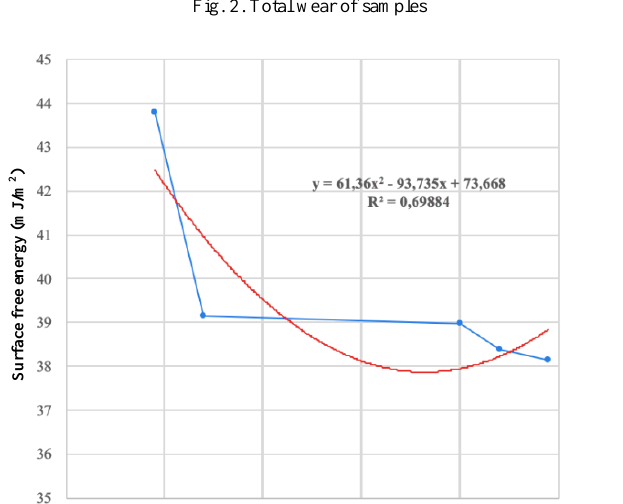
Fig. 2. Total wear of samples